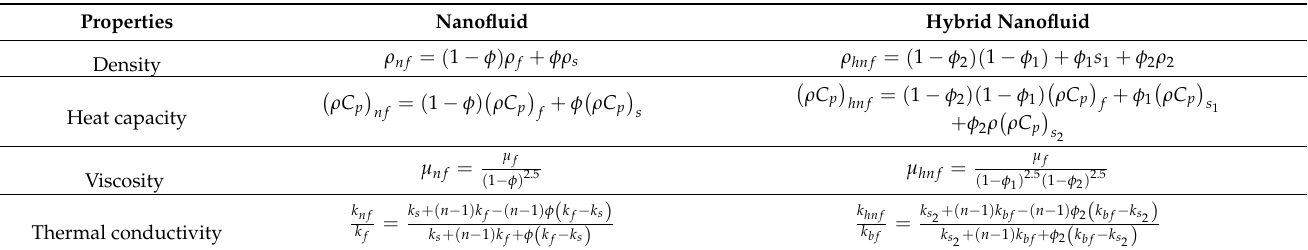
Table 5. Exhibits the thermo-physical